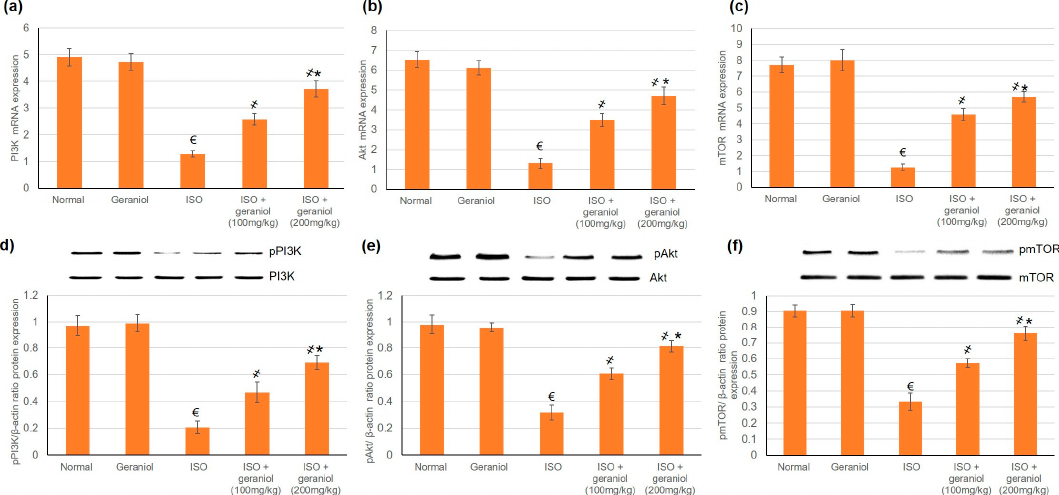
Table 2. The impact of geraniol pretreatment on ECG components in isoproterenol-induced myocardial infarction.